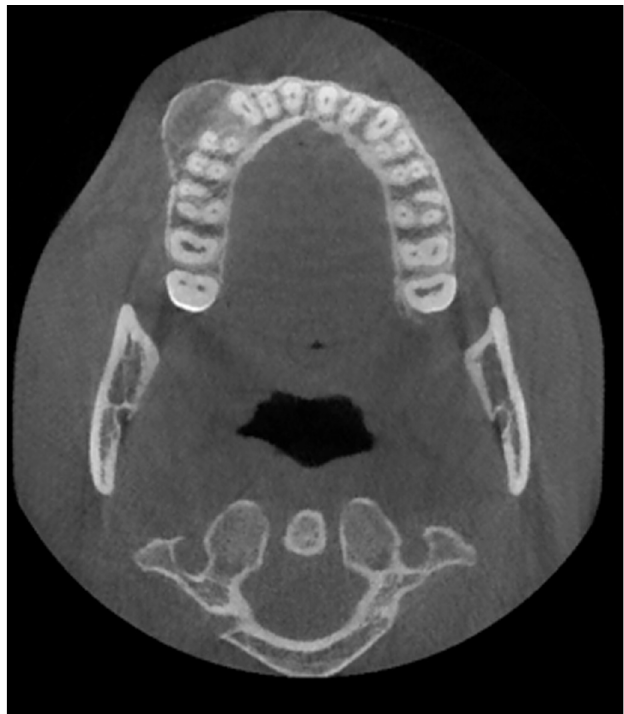
Fig. 3. Cone-beam CT highlighting a well-de fi ned right maxillary bone lesion consisting of homogeneous content compressing the cortex without traversing it. There are bone condensations within the